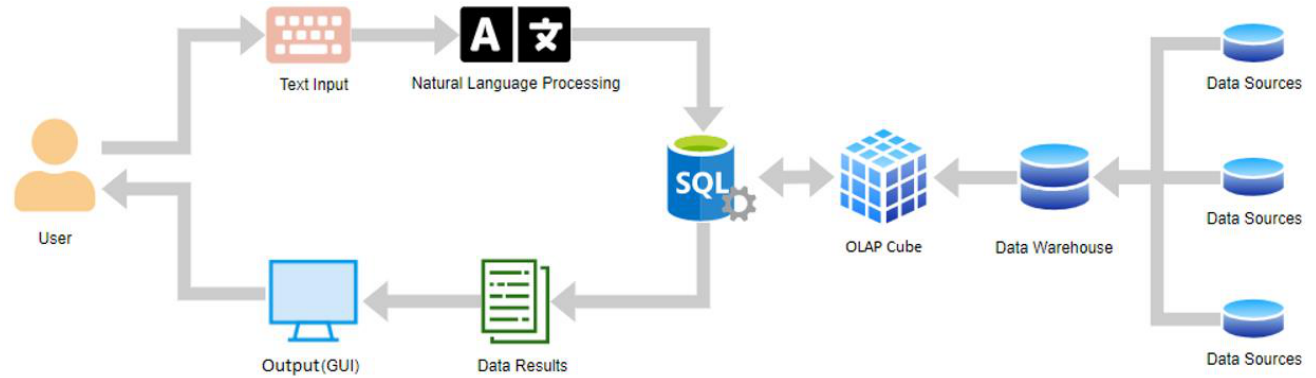
Figure 1. Model workflow .